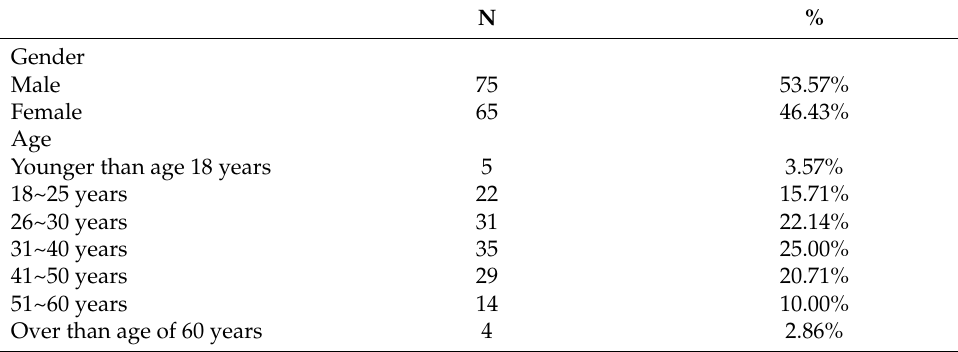
Table 4. Descriptive profile of the